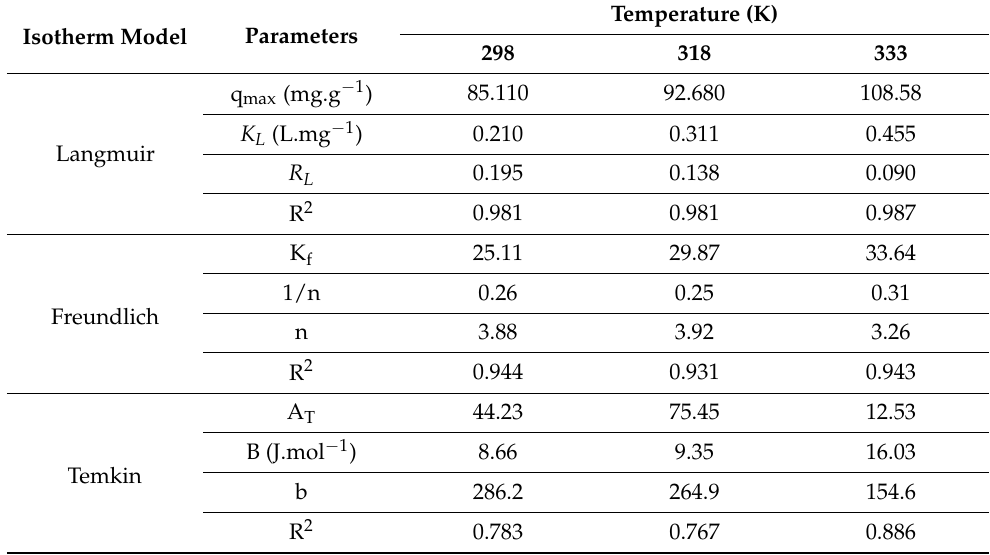
Table 3. Calculated values of adsorption isotherm parameters at different